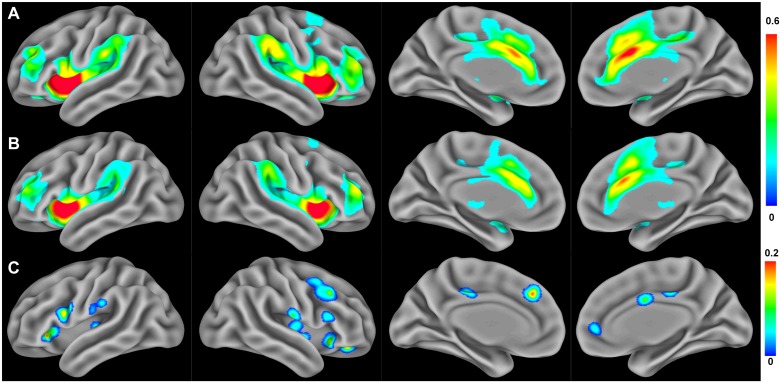
Resting state functional connectivity networks of the anterior insula.(A) Functional connectivity patterns in healthy controls and (B) patients with CRPS (FDR < 0.01, within-group analysis). (C) Brain areas showing a significant reduction in anterior insula functional connectivity in patients with CRPS relative to healthy controls (P < 0.005 for permutation test, between-group analysis).